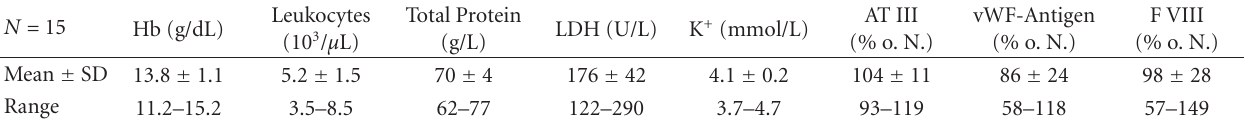
Table 2: Donors, initial